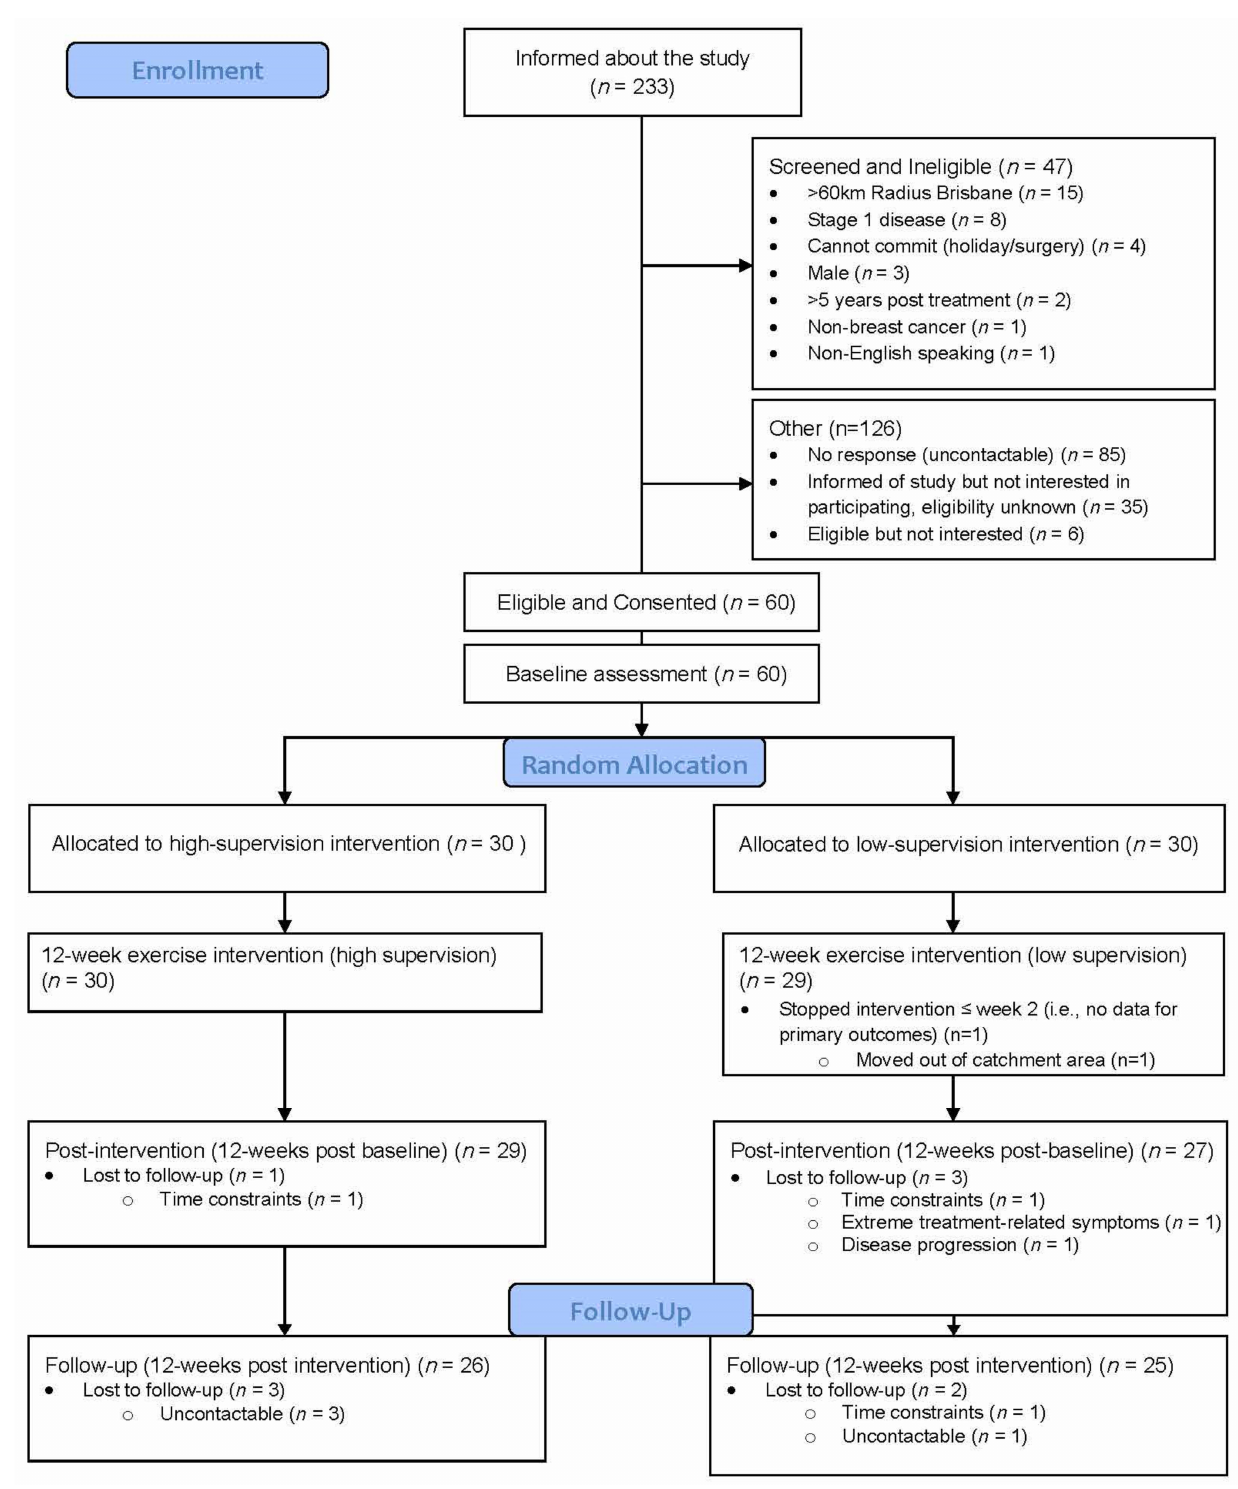
Figure 1. Flow diagram of recruitment and retention of